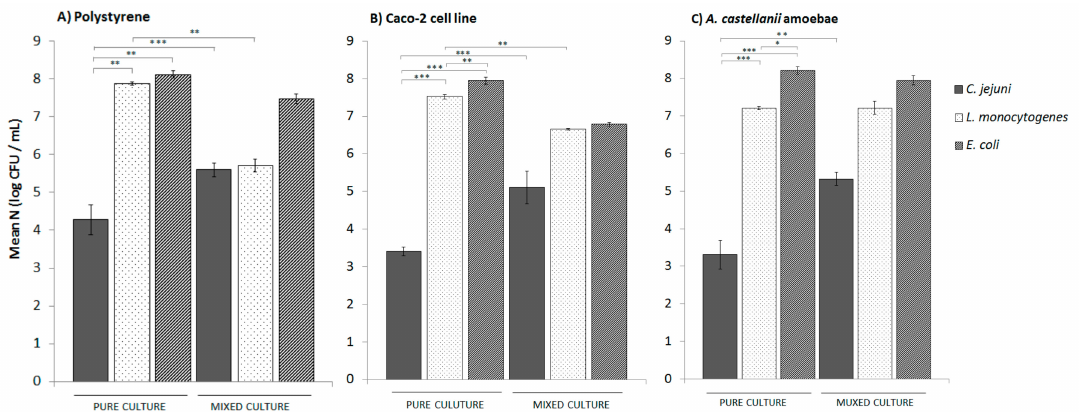
Figure 1. Adhesion of C. jejuni , E. coli, and L. monocytogenes as mono-cultures and as mixed